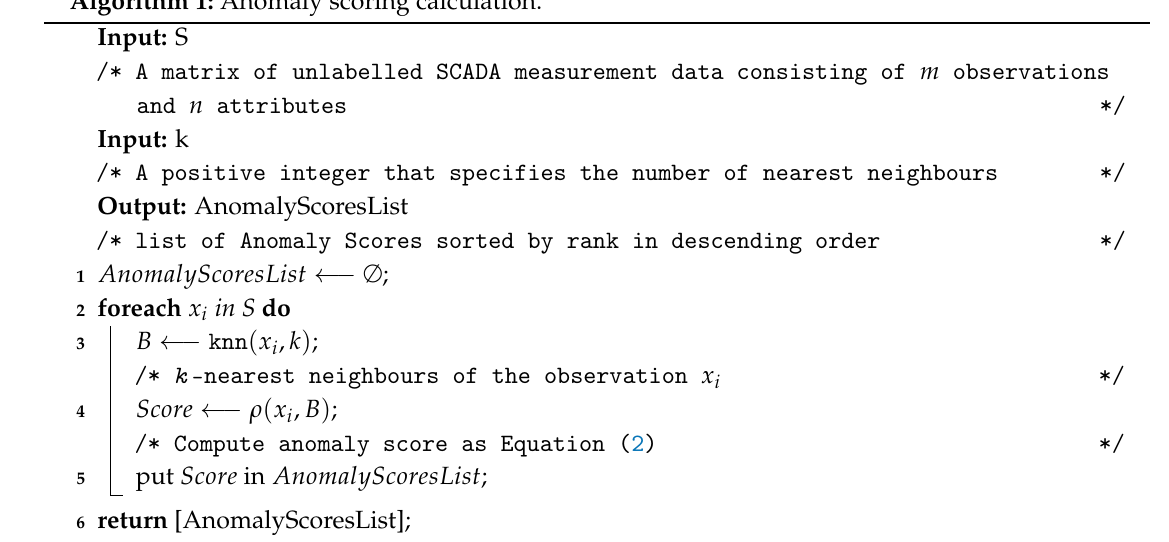
Algorithm 1: Anomaly scoring